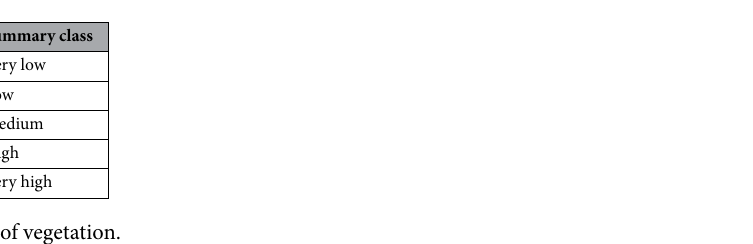
Table 4. Summary classes of